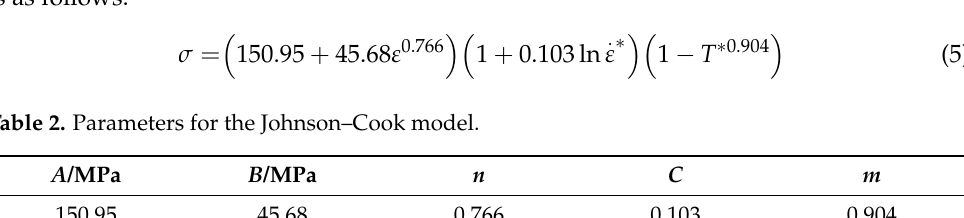
Table 2 shows the Johnson–Cook model parameters of Q345. The constitutive equation is as follows: